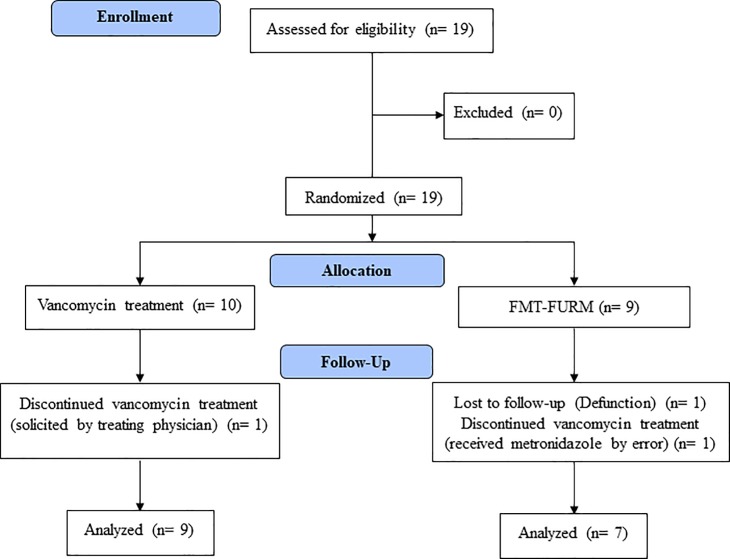
Flowchart of the study design.